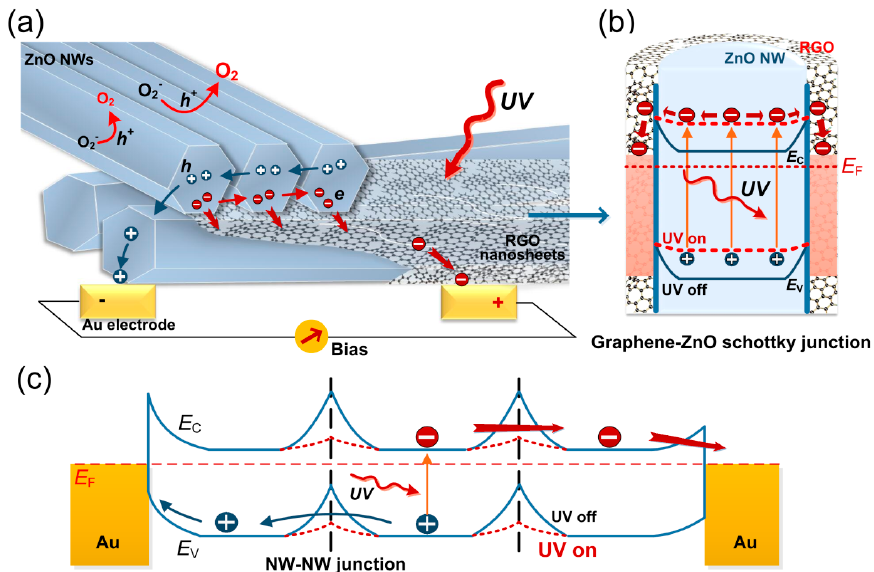
Figure 5. Schematic illustrations of work mechanisms of photodetectors based on RGO/ZNWs composite. ( a ) Charge transfer in ZNWs/ZNWs, RGO/ZNWs, and ZNWs (or RGO)/electrodes; Energy band diagrams of the contact interfaces in ( b ) RGO/ZNW and ( c ) ZNWs/ZNWs and their modifications in the profiles of conduction band and valence band along the nanowire radius and length in the dark and under UV